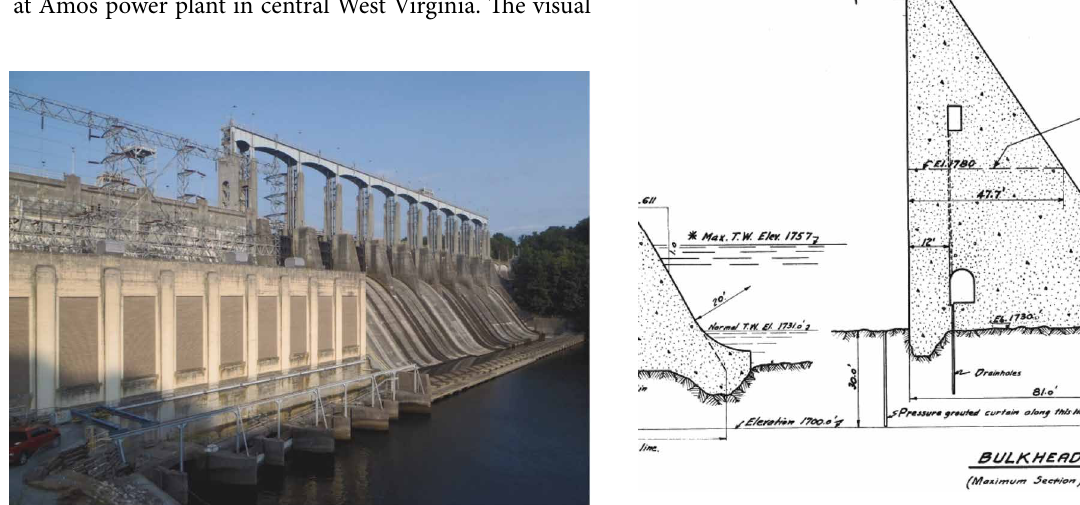
Figure 7. Claytor Hydroelectric dam cross section (from civil drawing provided by